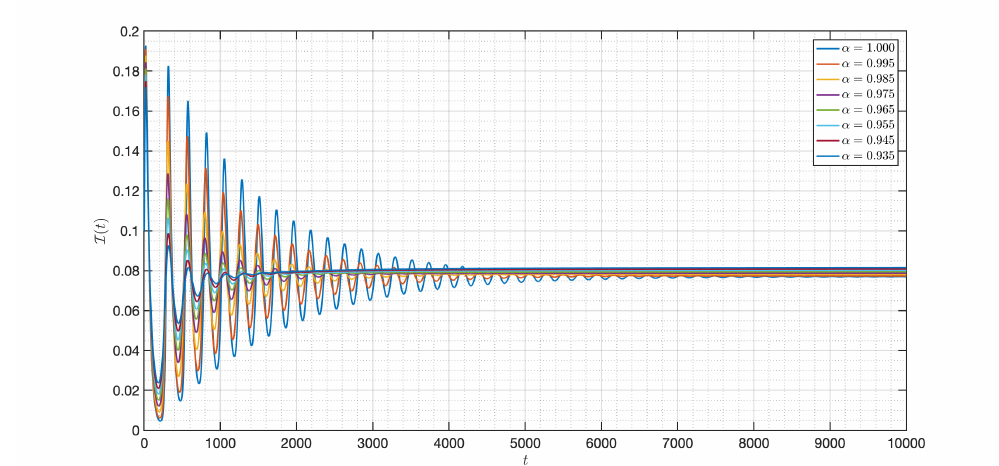
Figure 4. Dynamic of I ( t ) of the model (3) for different order α in Case I .